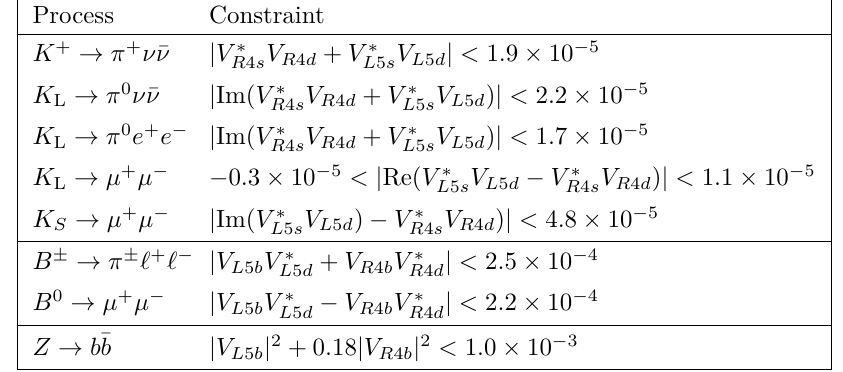
Table 9 . Limits on the mixing of the SM three families with the extra vector-like weak doublet q L 4 , qR 4 and the weak singlets u L 5 , u R 5 , d L 5 , d R 5 . See the text for constraints obtained from neutral mesons mixing and Z decay into